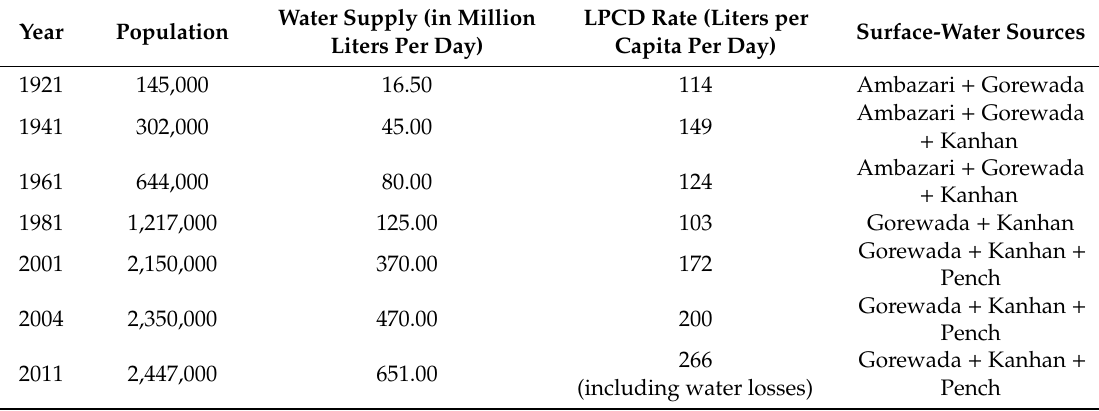
Table 1. Historical development of drinking-water sources for Nagpur